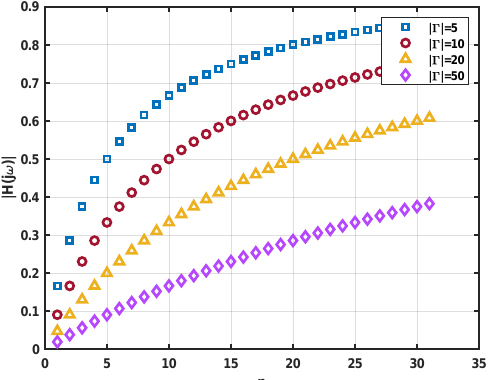
Figure 6. The transfer function of variable capacitor array. After passing through the polyphase filter, the differential cancellation signals are converted into four signals with the same amplitude and phase of 0°, 90°, 180° and 270°, which are respectively sent to the variable capacitor network after the active buffer. The variable capacitor network consists of four variable capacitor arrays; one variable capacitor array with M = 5 consists of 1 + 2 + 4 + 8 + 16 = 2 M − 1 = 31 variable capacitor units. Figure 7 shows the schematic diagram of the variable capacitor network and signal combiner circuit. Two polarity control bits and ten amplitude control bits can be set. The polarity control bits can control the polarity of the two orthogonal signals. The amplitude of each quadrature signal is controlled by 5-bit amplitude control bits. By adding the orthogonal signal vectors with different amplitudes, the cancellation signals with different amplitudes and phases can be obtained. Then, the received signal with a self-jammer is superimposed to complete the cancellation.